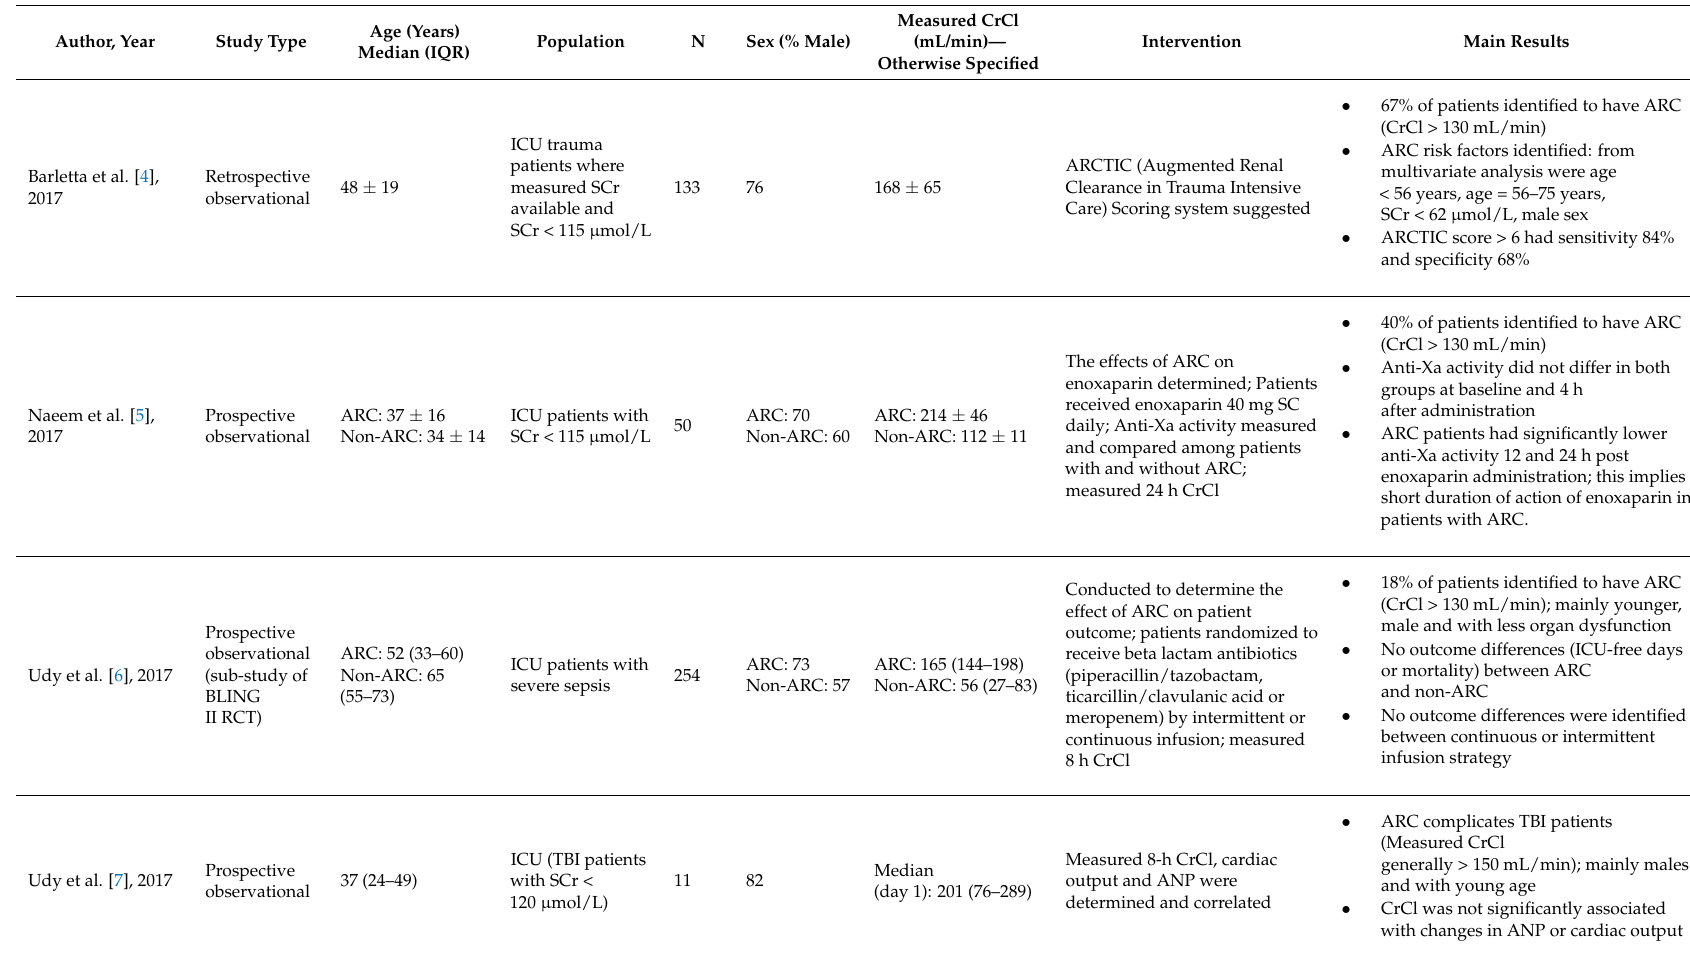
Table 1. Summary of studies pertaining to